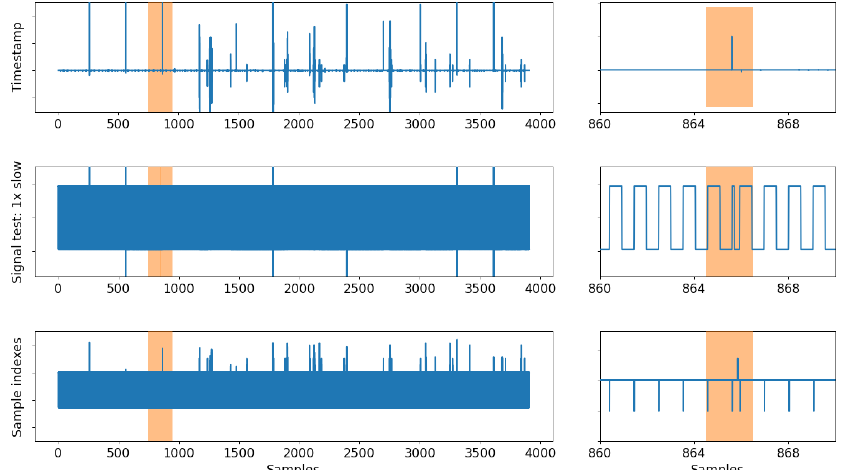
Figure 12. Sampling lost detection results. The sampling loss can be detected by analyzing the timestamp, using a test signal, or analyzing the sample index. Left column shows the complete time series in blue with a highlighted area. Right column presents a zoomed-in image regarding some samples